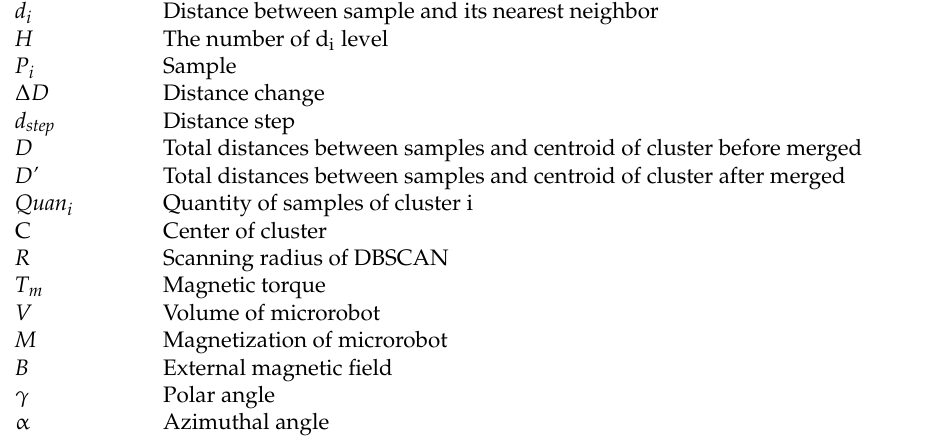
Table A2. List of